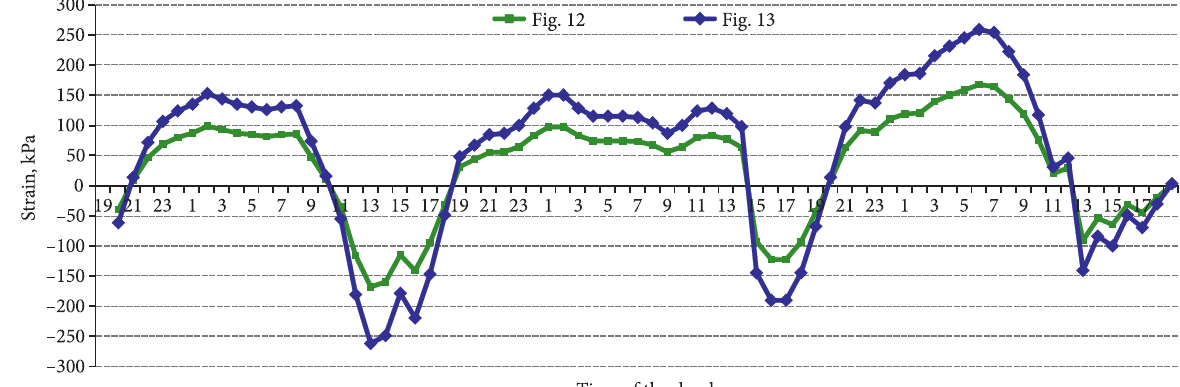
Fig. 22. Mode of deformation for the upper asphalt concrete layer presents stresses during the days with max positive temperatures (schemes in Figs 12 and